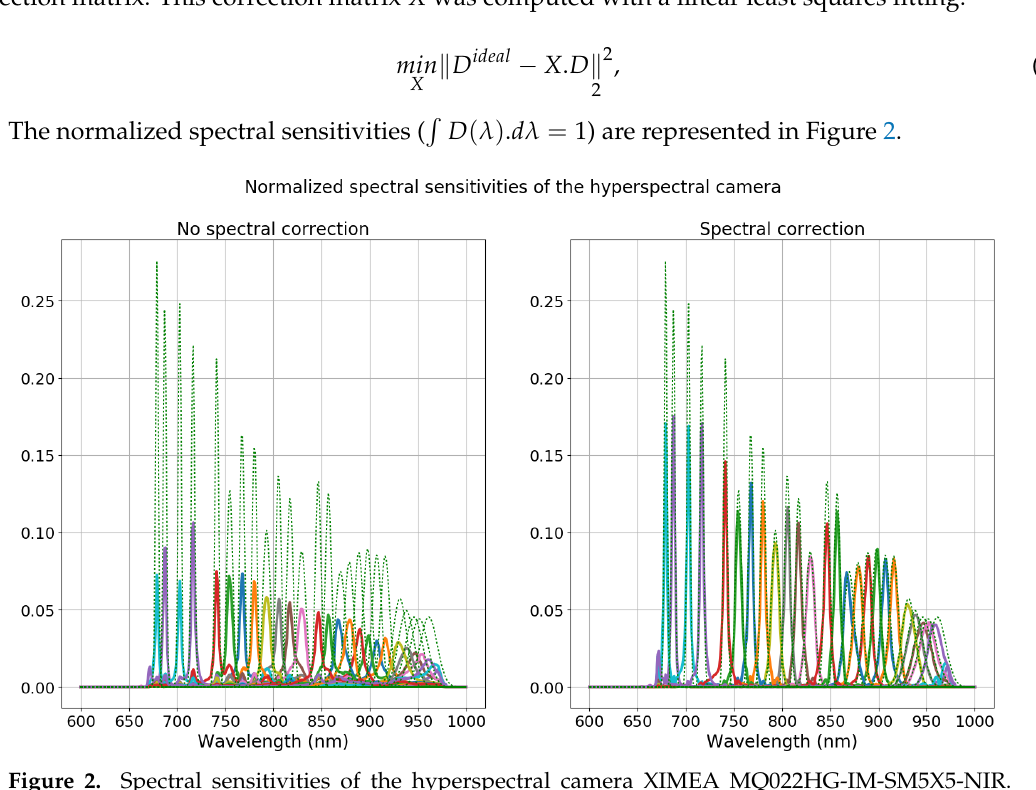
Figure 2. Spectral sensitivities of the hyperspectral camera XIMEA MQ022HG-IM-SM5X5-NIR. The uncorrected spectral sensitivities are plotted in solid lines on the left side of the figure and the corrected ones on the right side. The ideal spectral sensitivities are plotted in green dashed lines. (cid:82) D ( λ ) . d λ = 1) represents a probability density As the normalized spectral sensitivity (